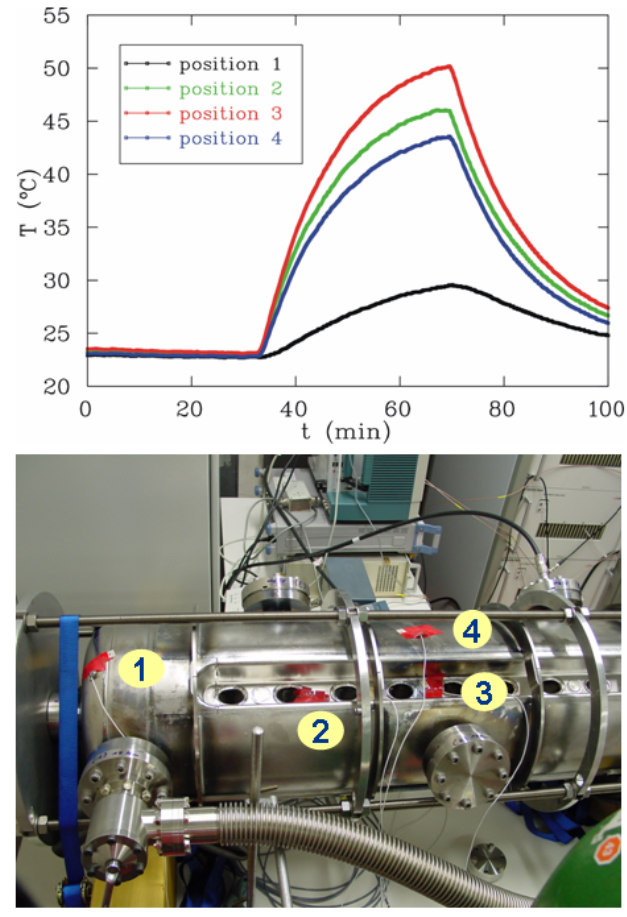
FIG. 26. (Color) Several temperature sensors have been placed at the cavity to measure the temperature increase due to rf power. Up to 300 W cw has been coupled to the cavity. Sensor 1 is located at the end-cell region, sensor 2 and sensor 3 close to the stem base, and sensor 4 is located at the outer tank wall. The higher the current density, the higher is the